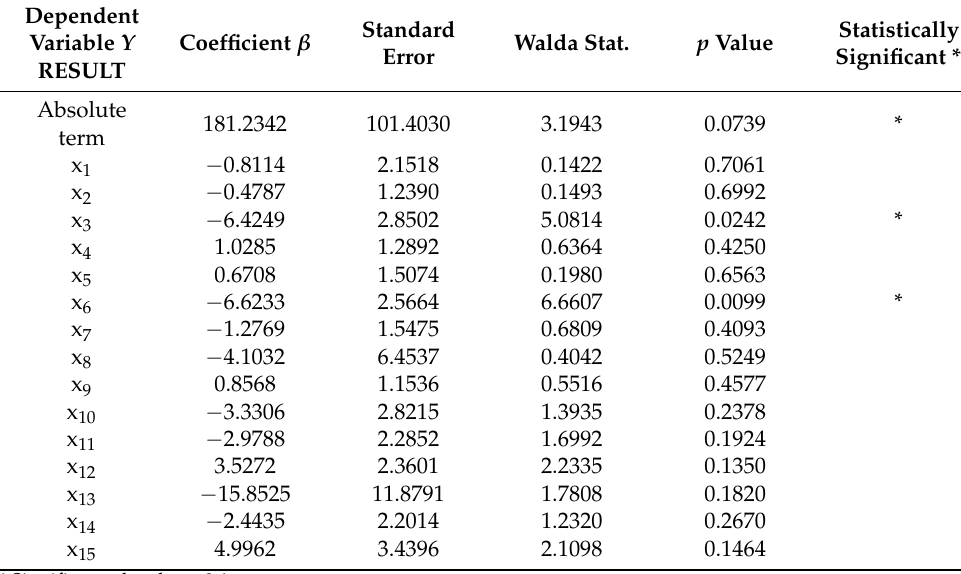
Table 3. Parameter estimates for the logit model—15 explanatory variables.